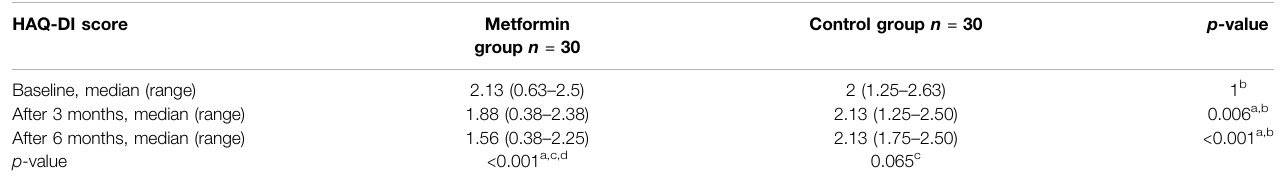
TABLE 3 | Comparison of Health Assessment Questionnaire-Disability Index (HAQ-DI) scores between and within the study groups. HAQ-DI